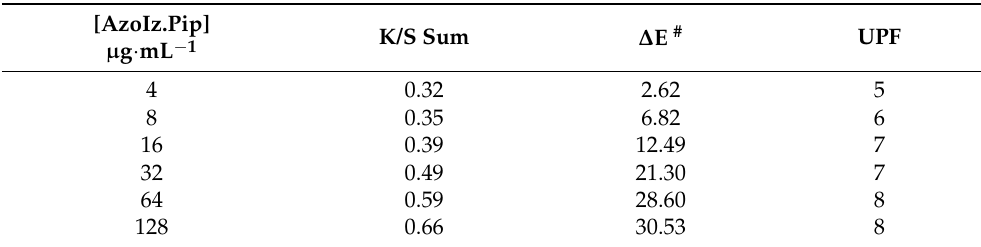
Figure 4. ( a ) K/S spectra of silk fabrics dyed with different concentrations of AzoIz.Pip dye under pH 6 and 40 ◦ C, and ( b ) solutions of the different concentrations tested before and after the exhaustion process; (c) K/S, ∆ E, and UPF values of the dyed samples. Table 5. K/S, ∆ E, and UPF values of the dyed silk samples with different concentrations of AzoIz.Pip under pH 6 and 40 ◦